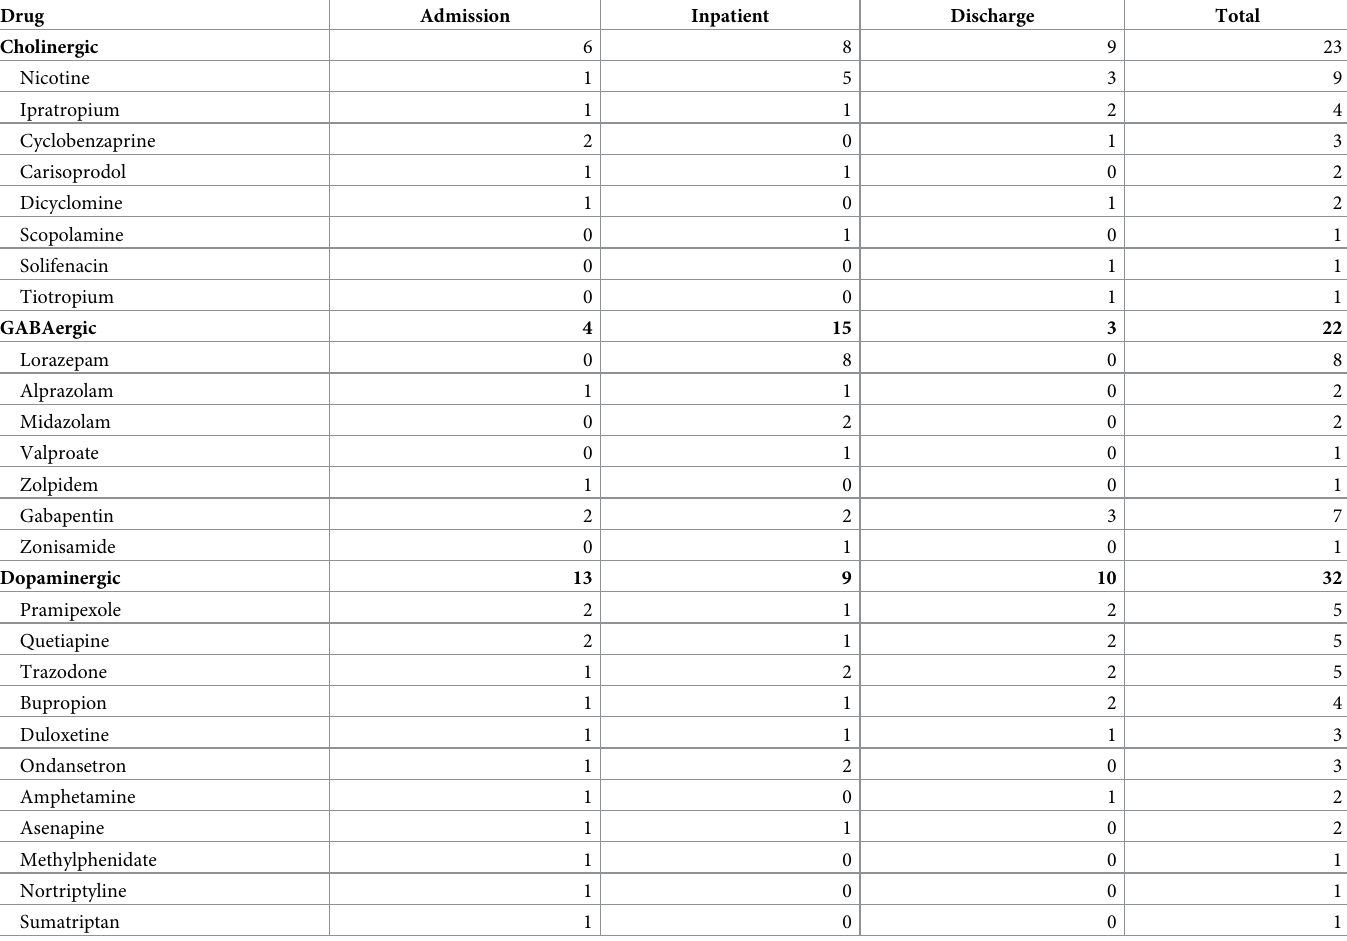
Table 1. N prescriptions by drug